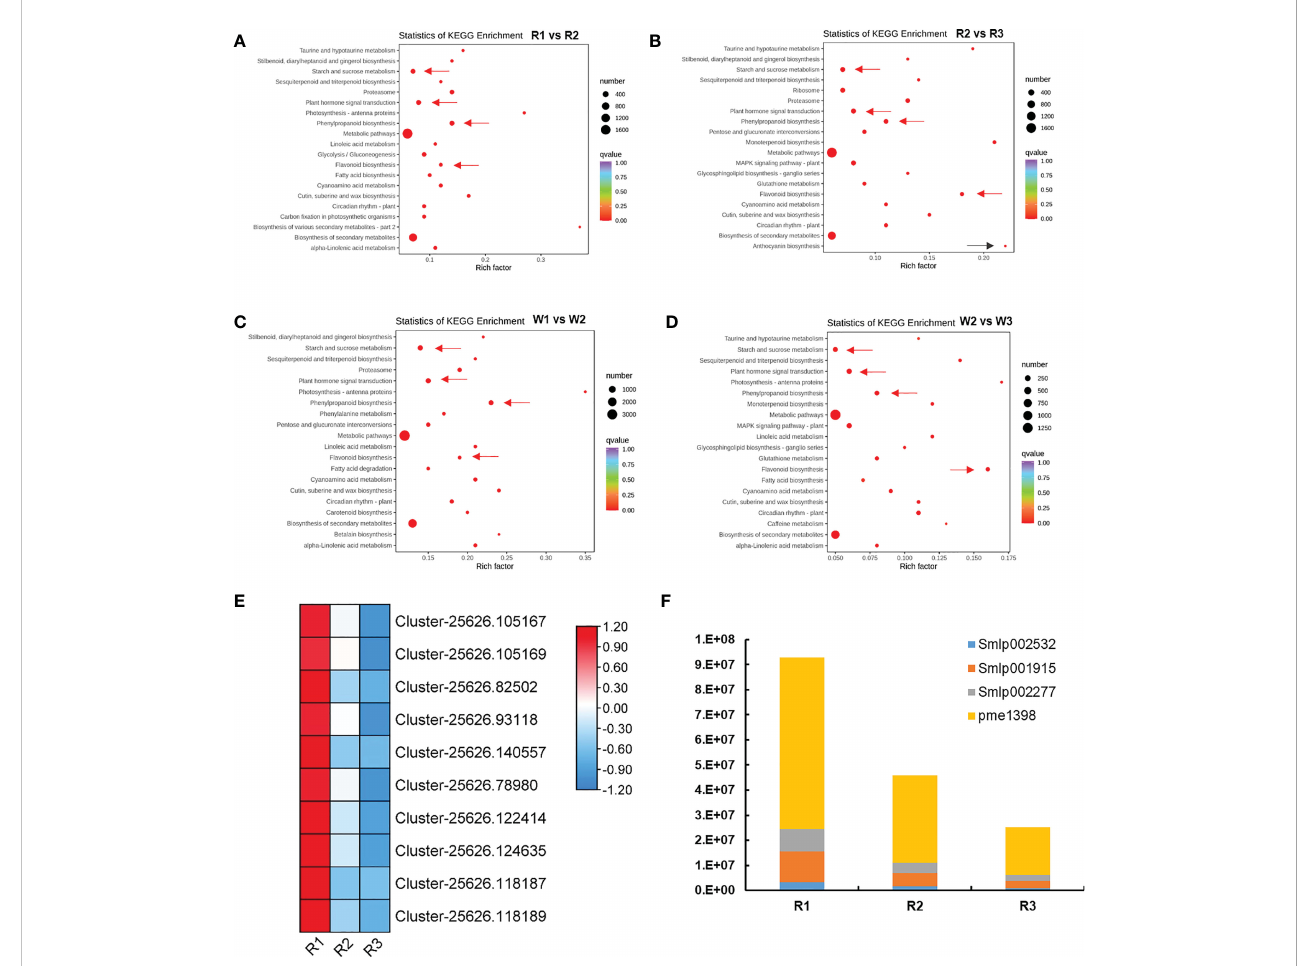
FIGURE 2 Analysis of the differentially expressed genes (DEGs) and fl ower color formation during nut fl ower development ( R and W refer to red and white nut fl owers, respectively). (A, B) Top 20 of the Kyoto Encyclopedia of Genes and Genomes (KEGG) enrichment of the DEGs in the R1 vs. R2 (A) and R2 vs. R3 (B) nut fl ower comparison groups. (C, D) Top 20 of the KEGG enrichment of the DEGs in the W1 vs. W2 (C) and W2 vs. W3 (D) nut fl ower comparison groups. (E) Expression changes of the DEGs in the anthocyanin biosynthesis pathway in R nut fl owers. (F) Changes of the anthocyanin differentially accumulated metabolites (DAMs) in R with the development of nut fl owers. The size of the red dots in the fi gure represents the number of enriched DEGs, and the redder the color, the more signi fi cant the enrichment. The arrows next to the red dots indicate the avenues that this article focused on. Each square in the heat map represents a gene, and the color bars represent changes in the gene expression, with red indicating upregulated gene expression and blue downregulated gene